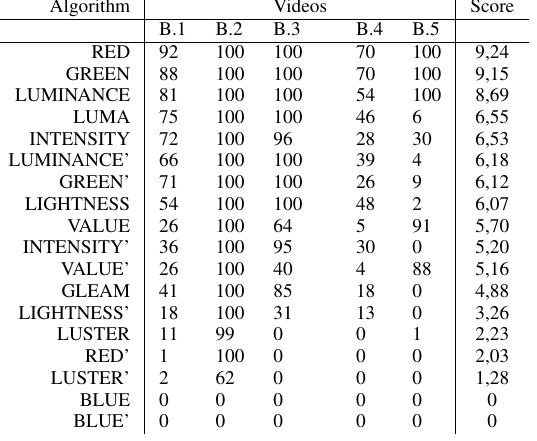
TABLE VII T EMPLATE 1: % OF TRACKED FRAMES AND THE SCORE PROPOSED